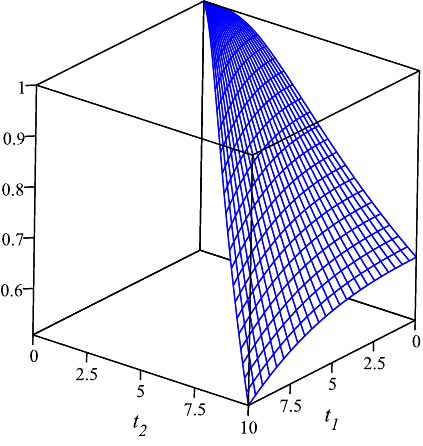
Figure 6. The joint reliability function of ( T 1 , T 2 ) in Example